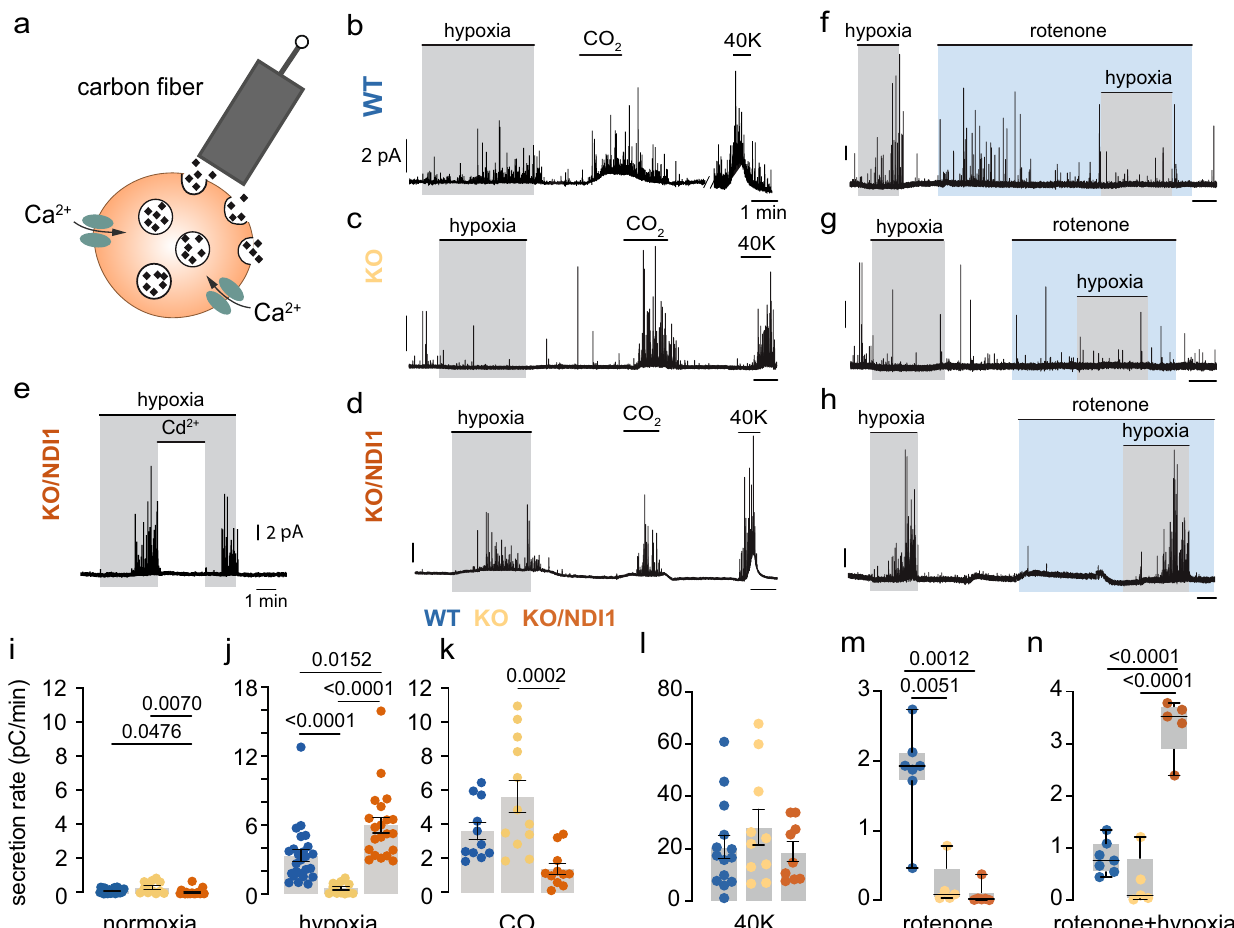
Fig. 3 | Rescue of the secretory response to hypoxia by transgenic NDI1 in mitochondrial complex I-de fi cient carotid body glomus cells. a Scheme illus- trating the amperometric recording of quantal dopamine release from a single glomus cell. Modi fi ed from ref. 20 . b – d Secretory responses of glomus cells in carotid body (CB) slices induced by hypoxia (O 2 tension ~15mmHg), hypercapnia (20% CO 2 ) and depolarization with potassium (40mMK) in wild type ( b ), KO ( c ) and KO/NDI1 ( d ) mice. The values ofthe calibrationbarsin ( b ),also apply to ( c , d ). e Inhibition of the secretory response induced by hypoxia in cells from KO/NDI1 mice by blockade of Ca 2+ channels with cadmium (200 µ M). f – h Secretory responsesofglomuscellsinCBslicestohypoxiaandrotenone(5 μ M)inWT( f ),KO ( g ),andKO/NDI1( h )mice.Calibrationbarsasindicatedin( b ). i – k Quanti fi cation(in picoCoulombs/min) of the basal secretion rate in normoxia and the secretory response to hypoxia and hypercapnia (CO 2 ) of the mouse models studied. Nor- moxia ( i ): WT, 0.19±0.03, n =26/21 cells/mice; KO, 0.37±0.1, n =12/7 cells/mice; KO/NDI, 0.10±0.04, n =21/10 cells/mice. Hypoxia ( j ): WT, 3.3±0.5, n =25/21 cells/ mice;KO,0.5±0.1, n =12/7cells/mice;KO/NDI1,5.9±0.7, n =21/10cells/mice.CO 2 , ( k ): WT, 3.6±0.5, n =11/9 cells/mice; KO, 5.6±1, n =12/7 cells/mice;